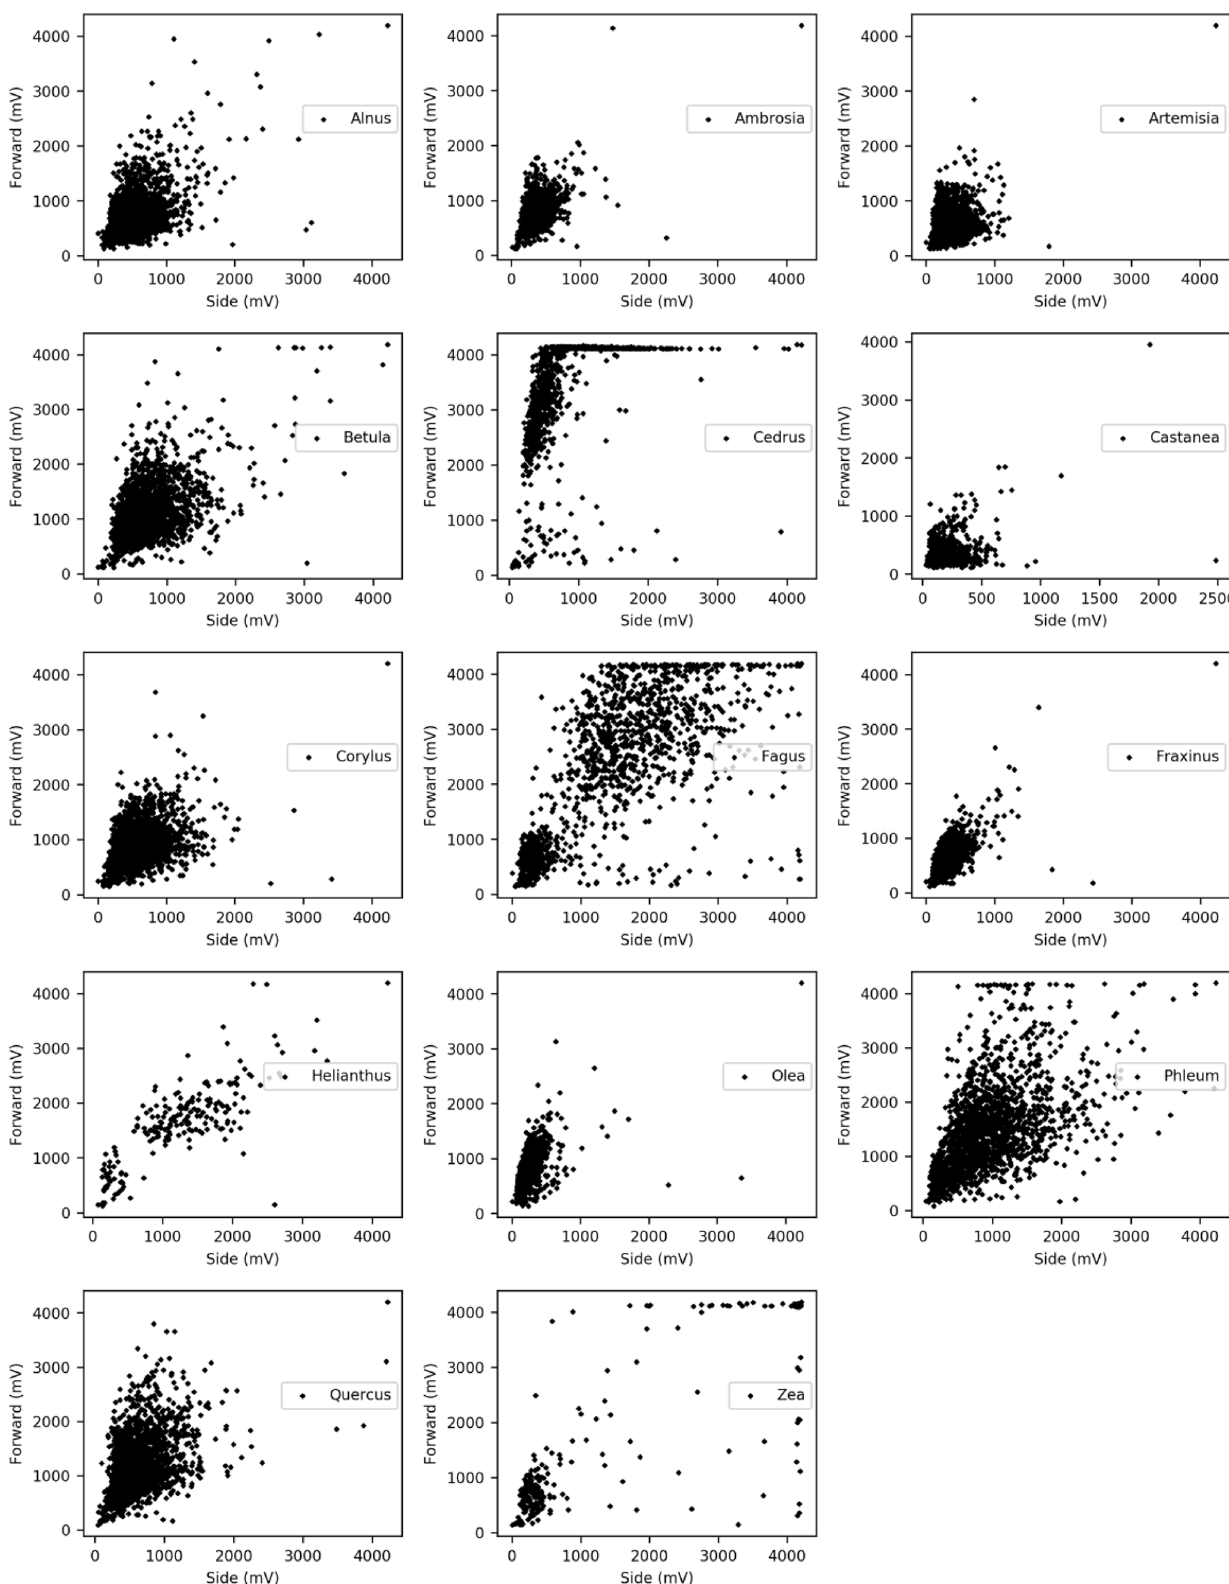
Figure 4. Light scattering distribution of various pollen